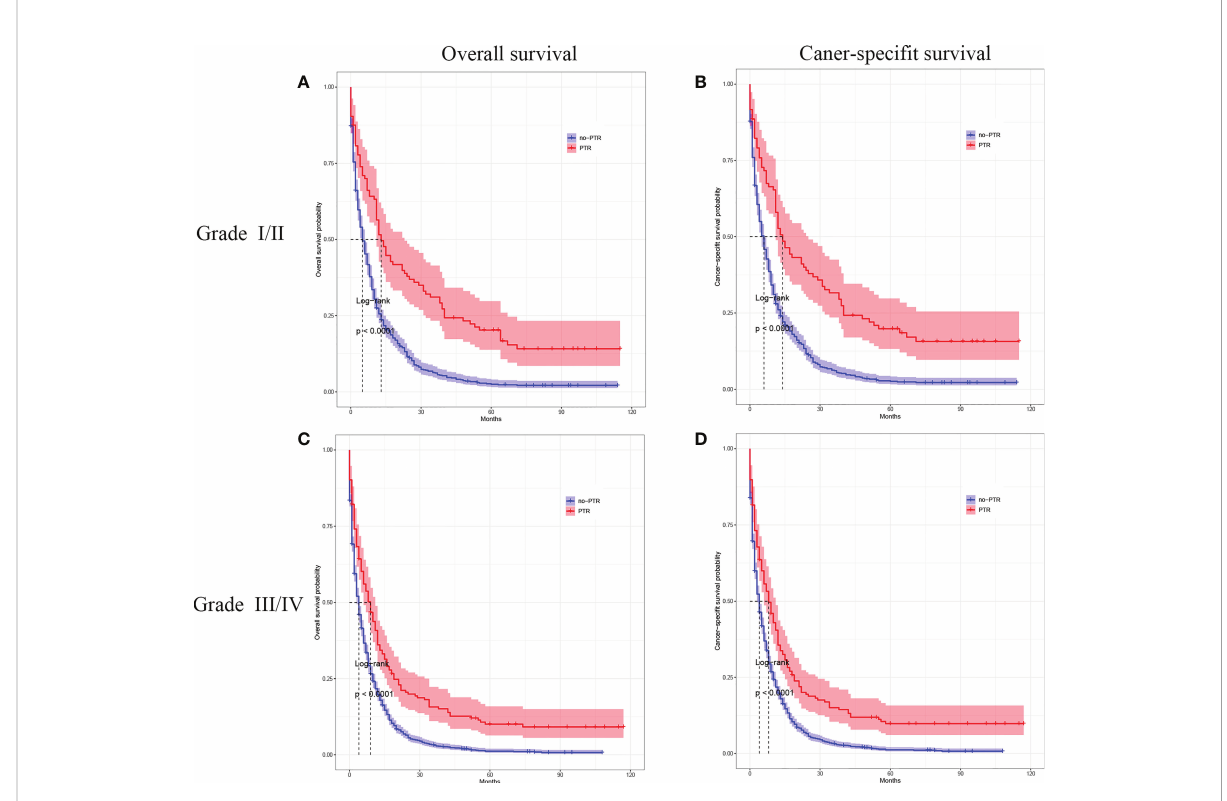
FIGURE 4 Kaplan – Meier curves for overall survival and carcinoma-speci fi c survival of patients with primary tumor resection versus without primary tumor resection strati fi ed by tumor differentiation in the unmatched